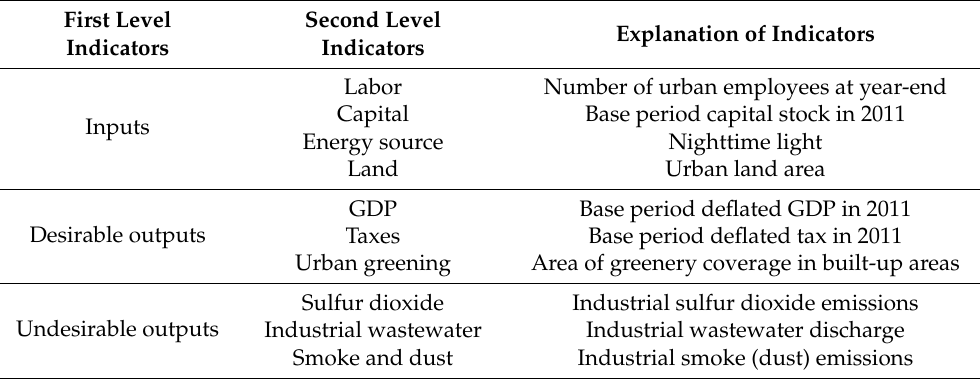
Table 2. Evaluation index system of urban EE in